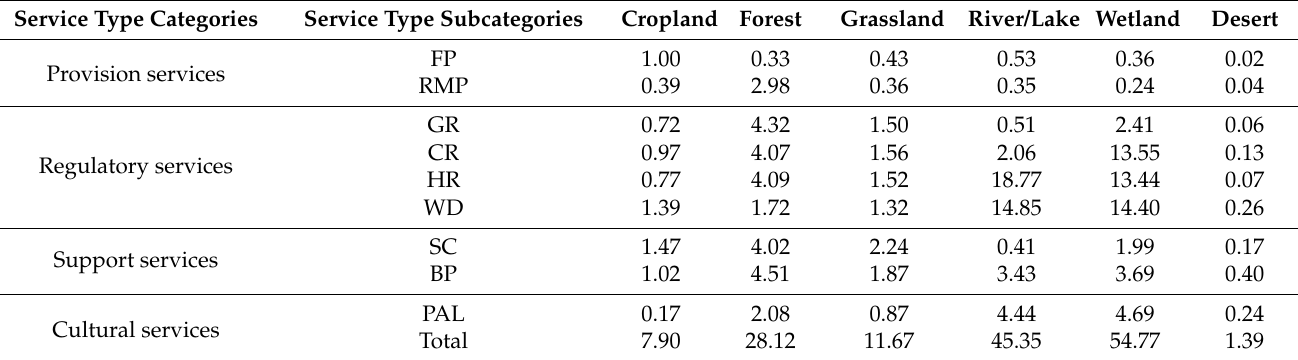
Table 1. Equivalent value per unit area of ecosystem services in China.